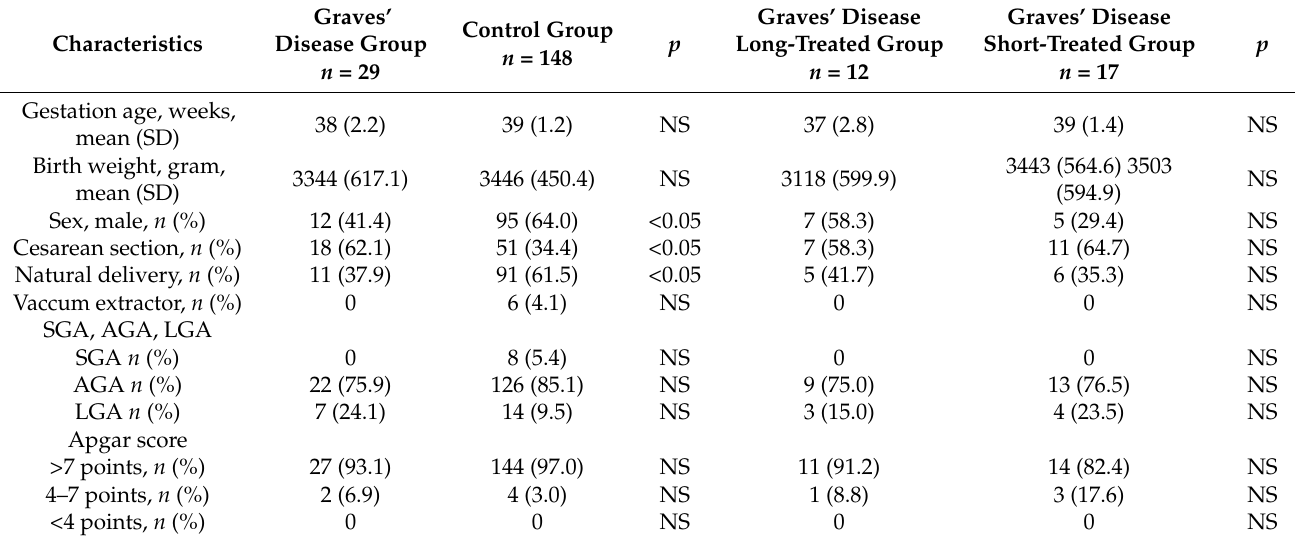
Table 1. Demographic characteristics of the study